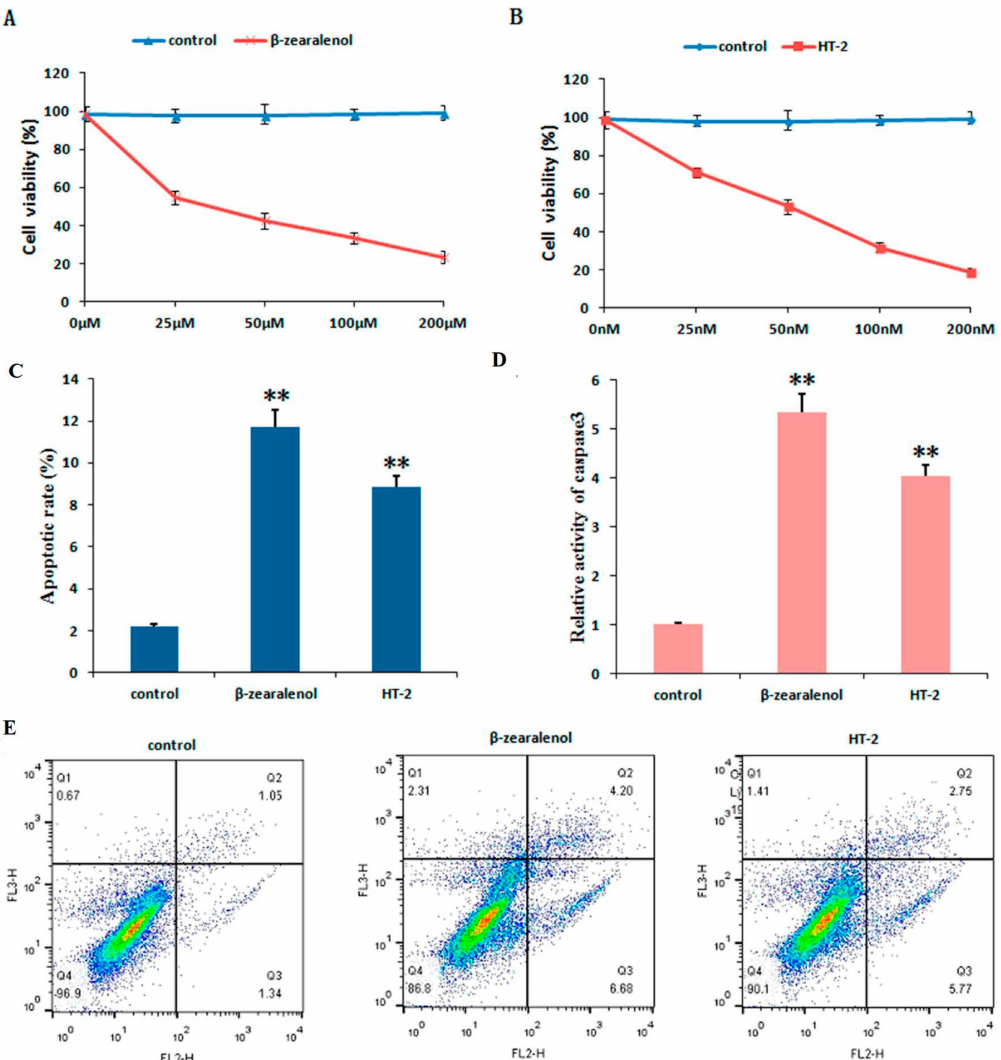
Figure 5. E ff ects of β -zearalenol or HT-2 on GC viability and apoptosis. The e ff ects of di ff erent concentrations of β -zearalenol and HT-2 toxins on the viability of bovine GCs using CCK8 ( A , B ). Apoptosis was detected via flow cytometry. After being exposed to β -zearalenol or HT-2 toxin for 24 h, GCs were collected for Annexin V-FITC / PI staining, followed by flow cytometric analysis ( C , E ). Cells were treated with β -zearalenol / HT-2 toxin for 24 h, and the cleaved-caspase-3 protein expression level was detected ( D ). Values are expressed the mean ± S.D. of n = 3. ** p < 0.01 versus that of the control group; CON, control group; β -zol, β -zearalenol treatment; HT-2, HT-2